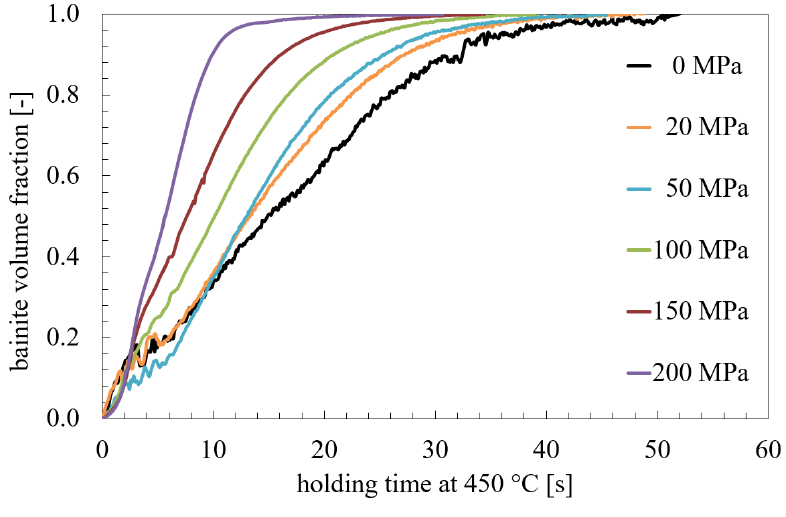
Figure 1. Kinetics of the bainitic transformation in regard of applying different stresses [39].